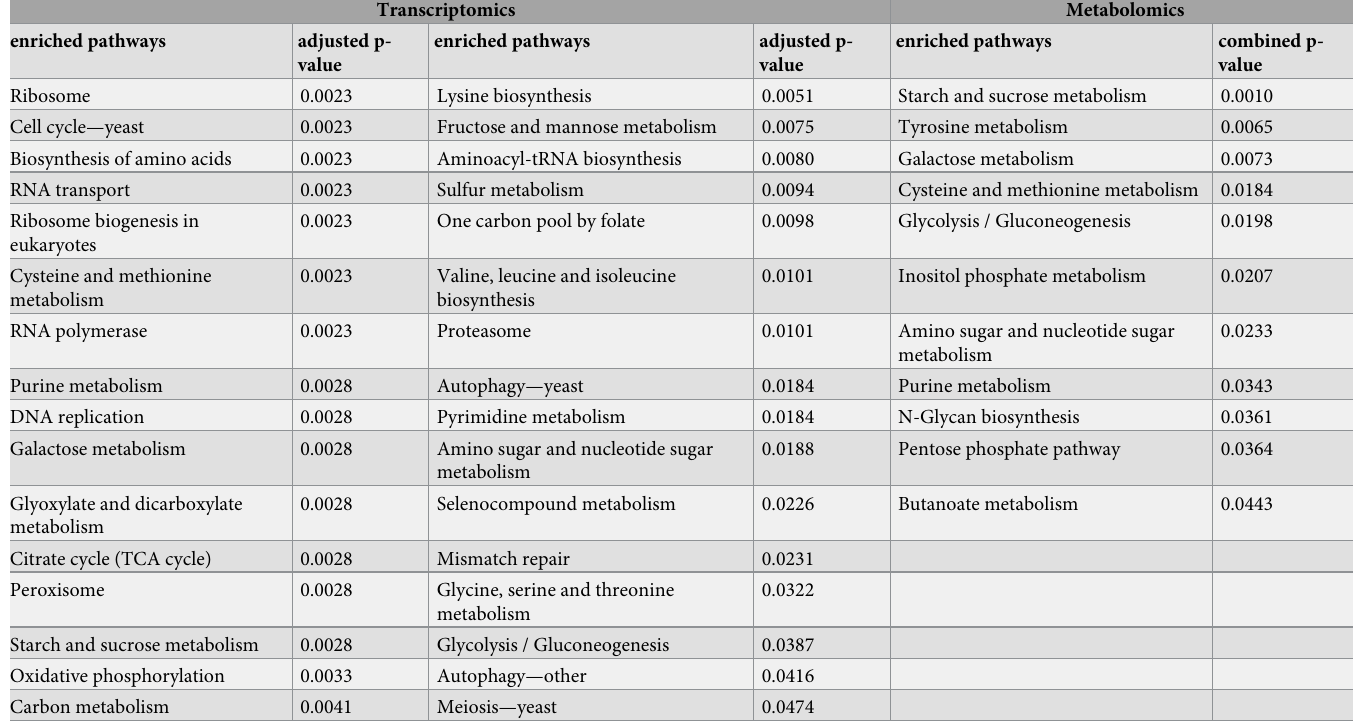
Table 1. Single-omics analysis results for wildtype comparing 2% (H) and 0.05% (L) glucose. First block shows GSEA for transcriptomics with adjusted p-value < 0.05, arranged in ascending order; second block shows MetaboAnalystR pathway enrichment analysis for metabolomics with combined p-value < 0.05 arranged in ascending order, as detailed in Methods. Enriched pathways refer to classifications provided in KEGG. Transcriptomics